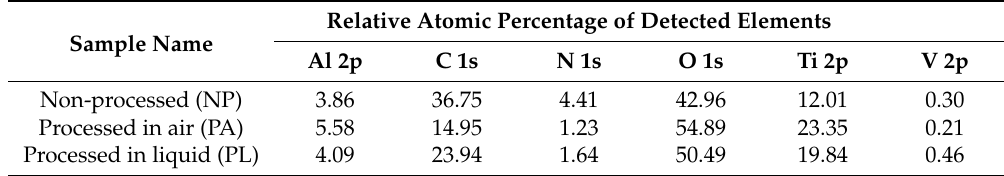
Table 3. Relative atomic percentage of element obtained from X-ray photoelectron spectroscopy (XPS).